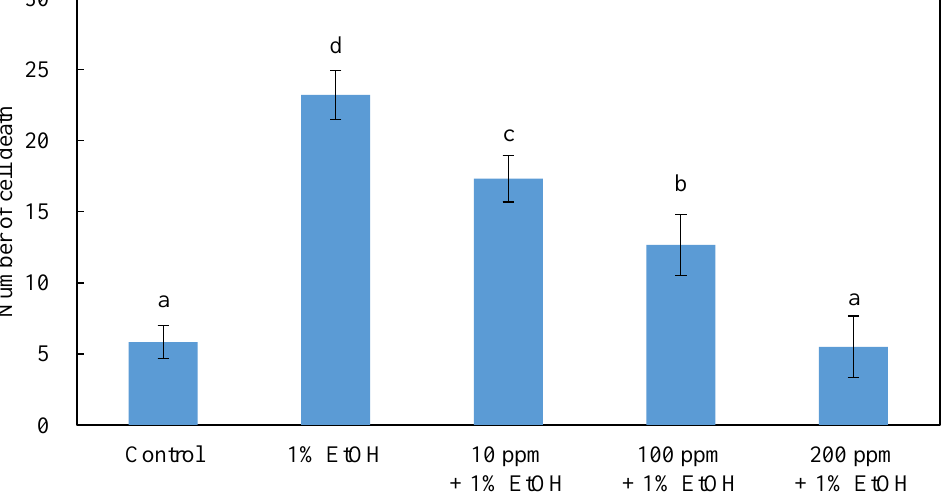
Figure 4. Effect of pretreatment with different concentrations of a hot water extract of Hericium erinaceus solid-state fermented wheat product (HEWE) on the brain cells of zebrafish embryo. The bar graphs represent the mean number of acridine orange-labeled cells, mean ± S.D.; n = 8 embryos. a–d The mean cell death values with different letters are significantly different ( p < 0.05).